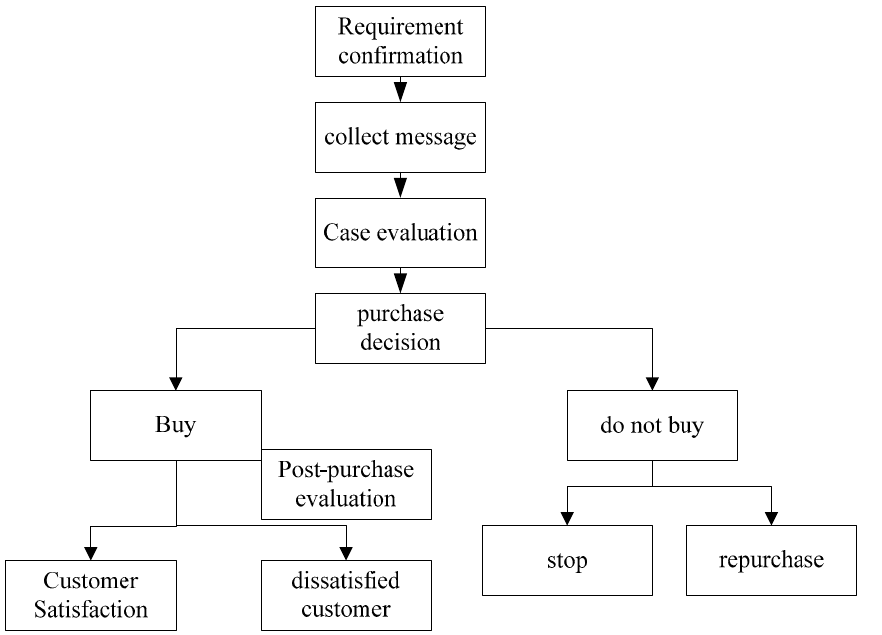
Figure 7. Schematic figure of insurance consumer